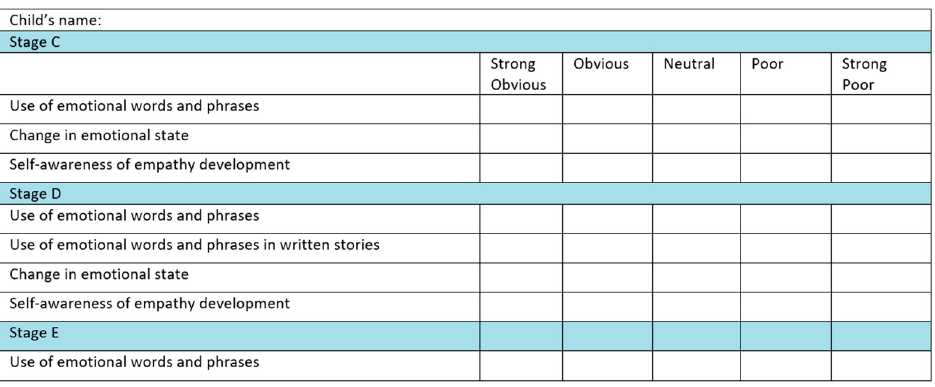
Figure 6. The evaluative rubric regarding the development of children’s